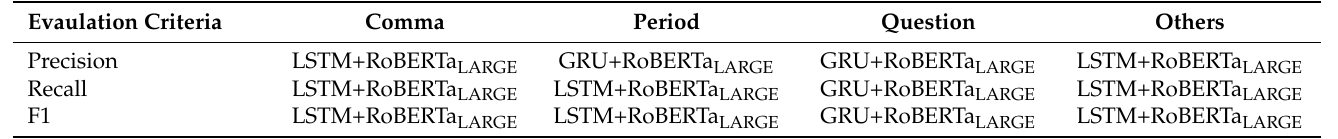
Table 9. Test evaluations based on